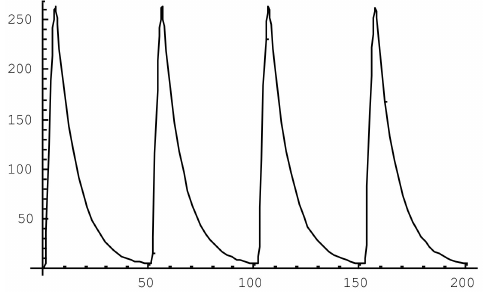
Figure 7. Diagram obtained via simulation.